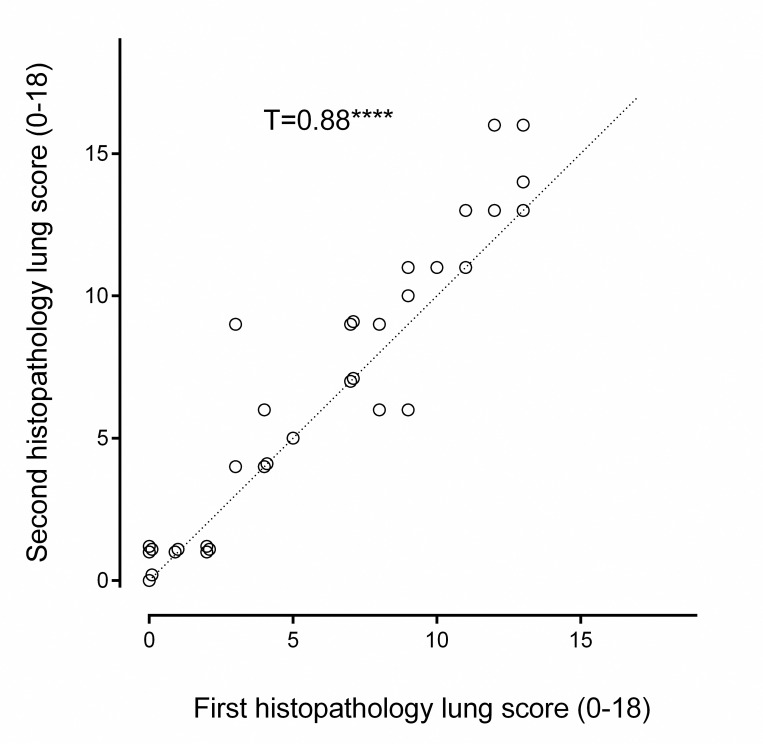
Scatter dot plot showing individual histopathology scores using the modified scoring system (SS) compared with a second scoring (SS) eight months later (n = 35).This was to calculate the Intra-observer repeatability of the modified histopathology scoring system. Kendall rank order coefficient T = 0.88, z = 7.44, p≤0.00003. NB some similar values that overlapped have been nudged so that the data points can be seen.